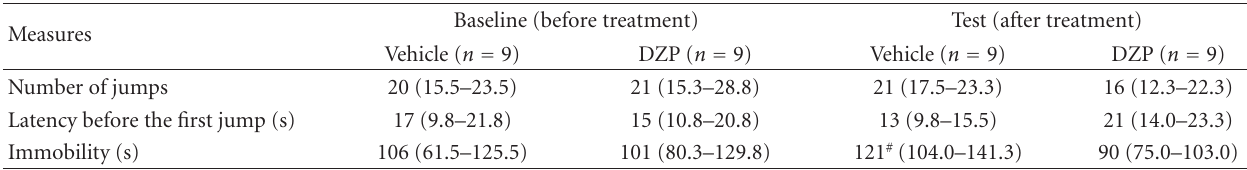
Table 3: E ff ects of acute diazepam (DZP) treatment (1mg/kg, IP, n = 9, median with limits of interquartile range values). Wilcoxon-test: # P < 0 . 05 (test versus baseline). Data were expressed as median with limits of interquartile range values.